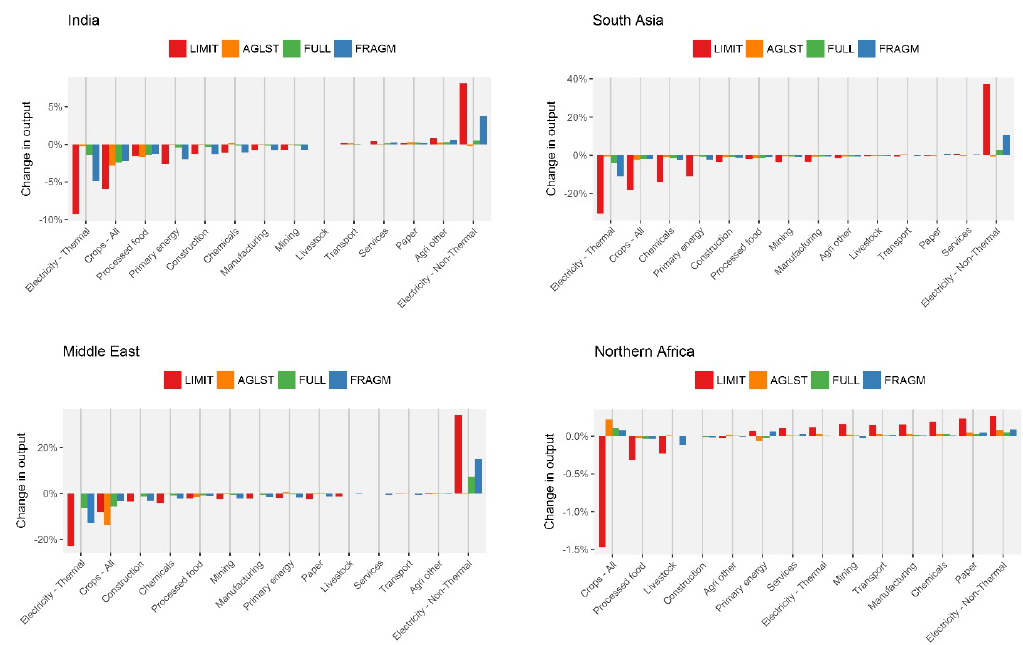
Figure 5. Sectoral output impacts in water‐scarce regions.